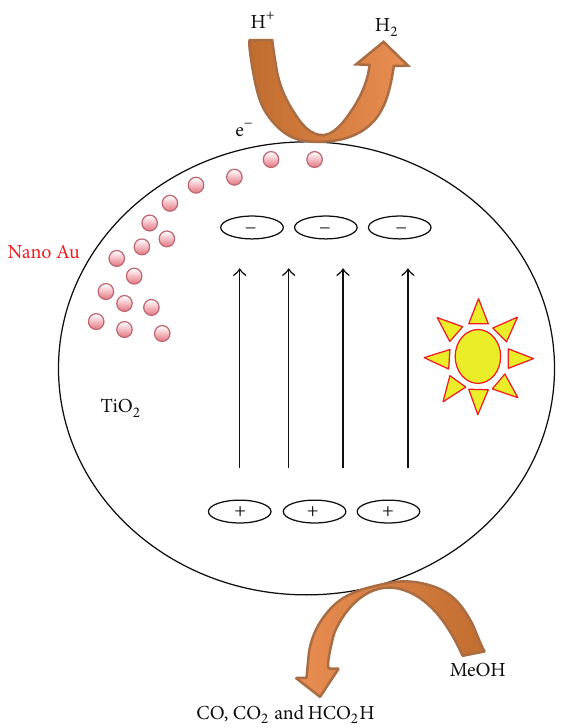
Figure 3: Au/TiO 2 catalysts, easily prepared in situ from different Au precursors and TiO 2 , generate H 2 from H 2 O/alcohol mixtures